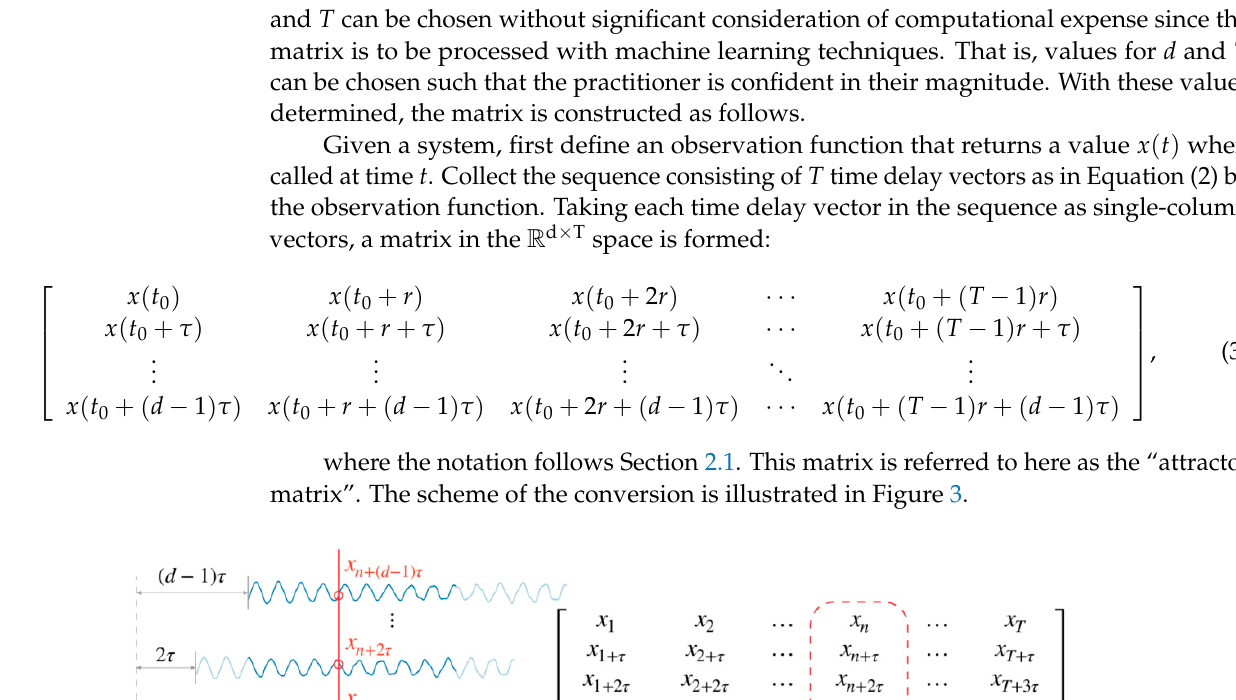
scaled to 0–255. Each element of the matrix then represents a pixel in a grayscale image.